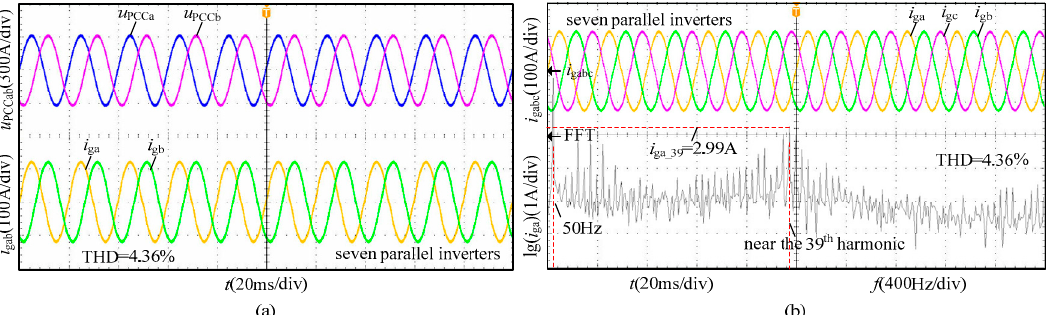
Figure 20. Experimental waveforms of PCC voltage u PCC and the grid-connected current i g in case II (seven parallel inverters). ( a ) PCC voltage u PCC and grid-connected current i g ; ( b ) grid-connected current i g and spectrogram.